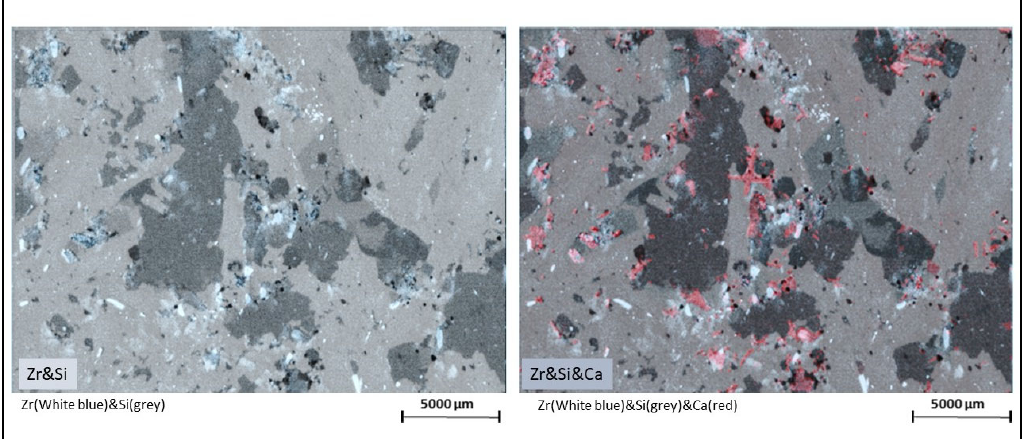
Figure 11. Elemental spatial micrometric distributions between Zr&Si and Zr&Si&Ca.